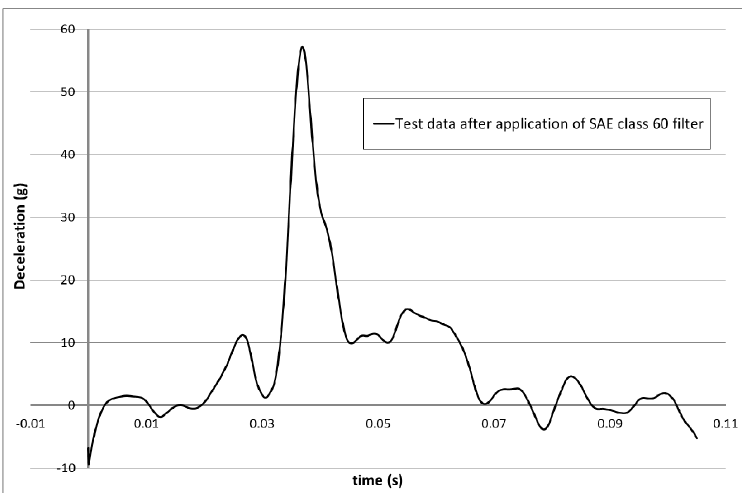
Figure 10. Deceleration against time obtained from the impact test.